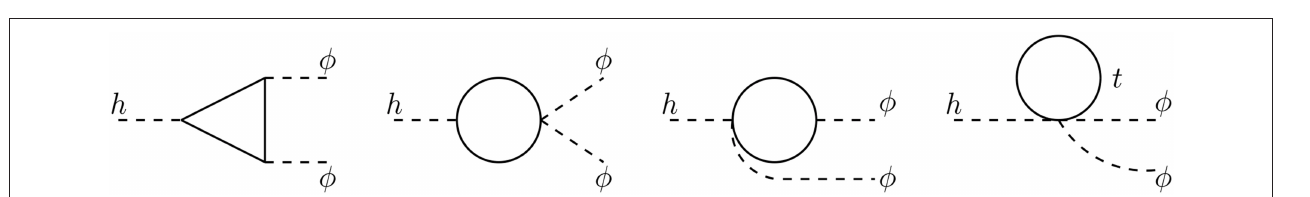
FIGURE 2 | Leading contributions to the decay h